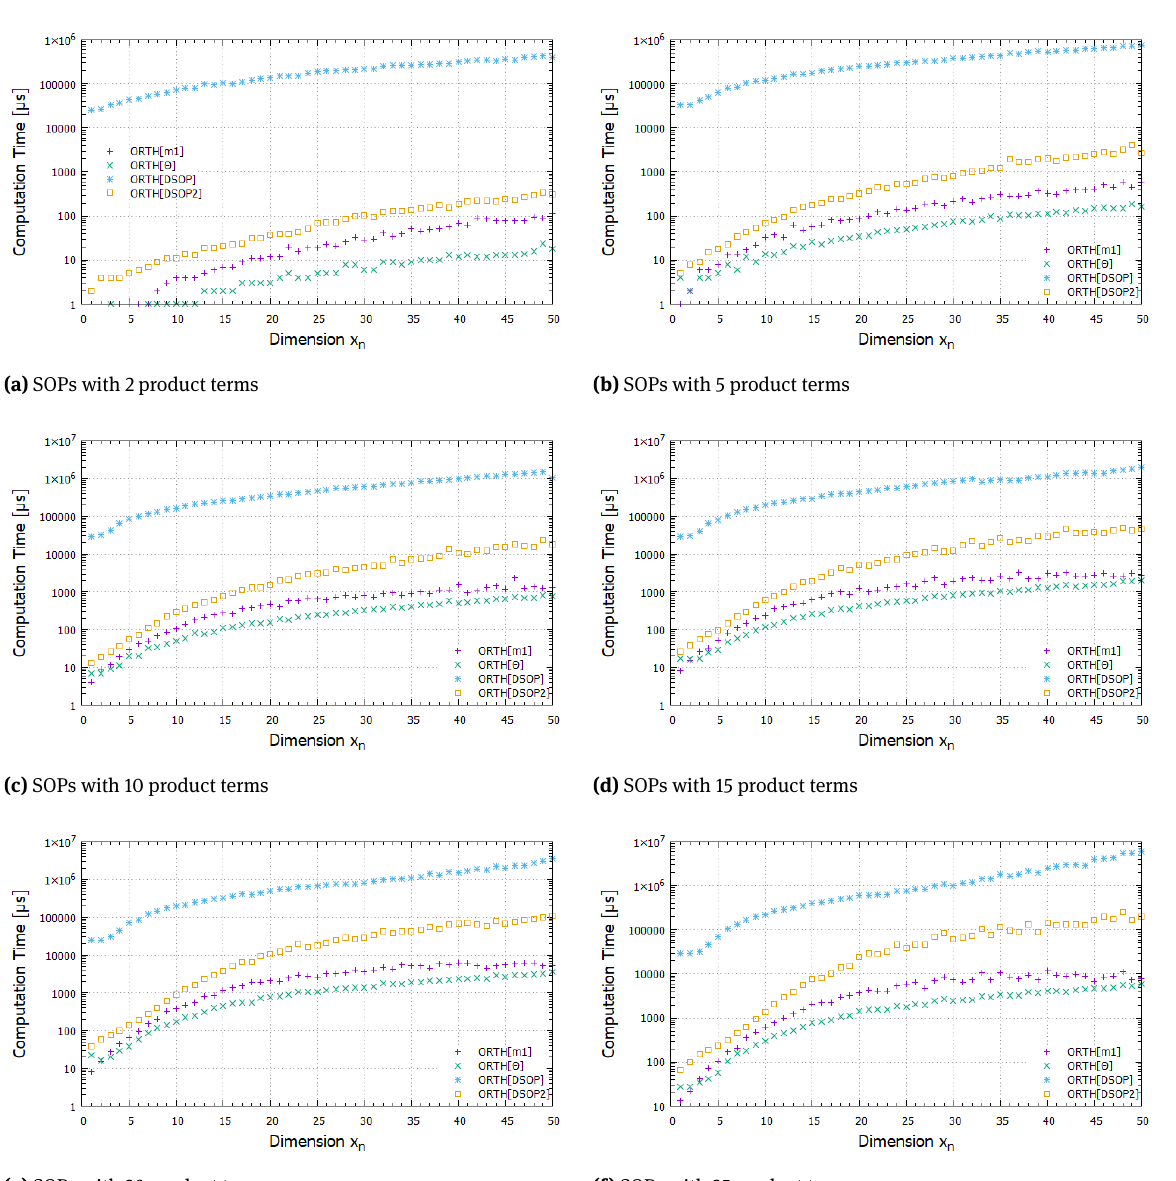
Figure 6: Comparison in computation